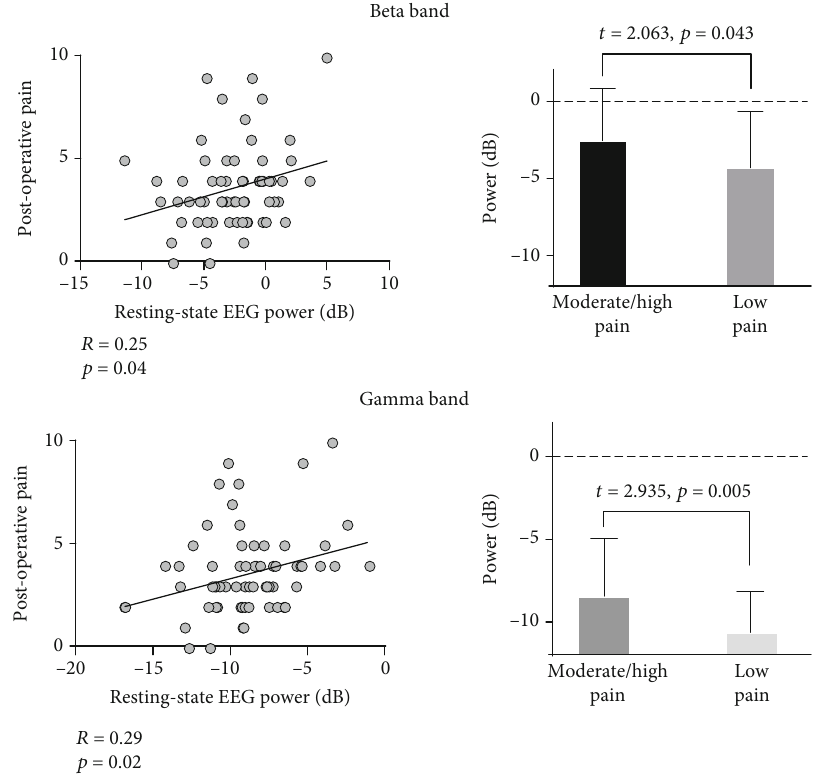
Figure 3: The relationship between postoperative pain and resting-state EEG powers at beta (14-30Hz) and gamma (31-50Hz) frequency bands. Left : partial correlation was performed after controlling age and removing outliers. Right : independent-sample t -tests were performed between patients with di ff erent levels of acute postoperative pain, i.e., moderate/high pain and low